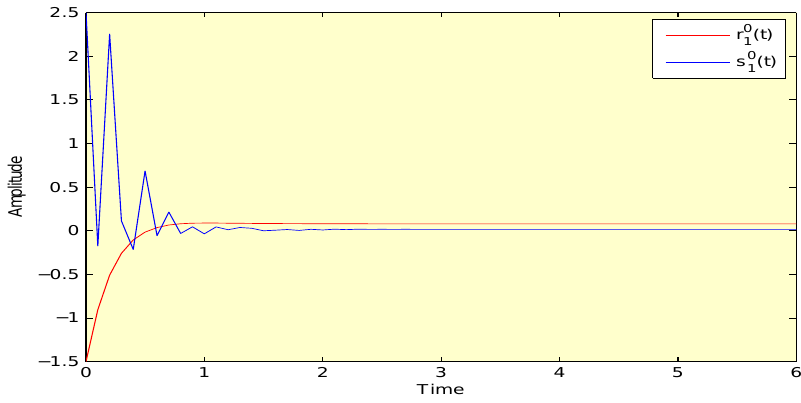
( t ) , (cid:115) 0 ( t ) of NN models (1) and (3). 1 1